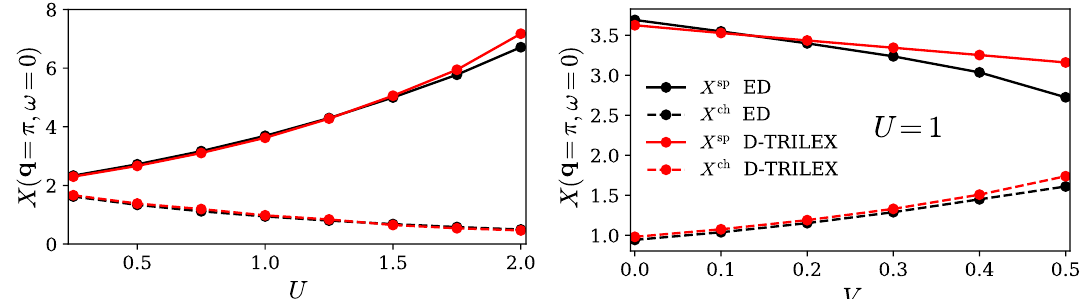
Figure 5: Spin (full lines) and charge (dashed lines) static ( ω = 0) susceptibility X obtained at the q = π point for the half-filled system with model parameters t = 0.5, J = U / 4, and β = 10. The left panel shows the result as a function of the local interaction strengths U in the absence of the non-local interaction ( V = 0). The right panel illustrates the susceptibility as a function of V calculated for the fixed value of the local interaction U =